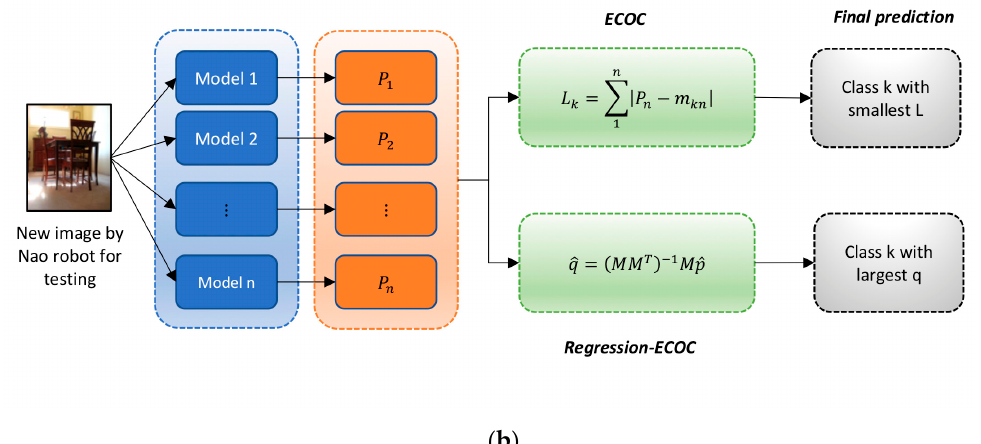
Figure 2. Error correcting output code (ECOC) process for addressing multi class learning problems. ( a ) Stage 1: training all binary classifier processes, and ( b ) Stage 2: predicting a class of new image process.